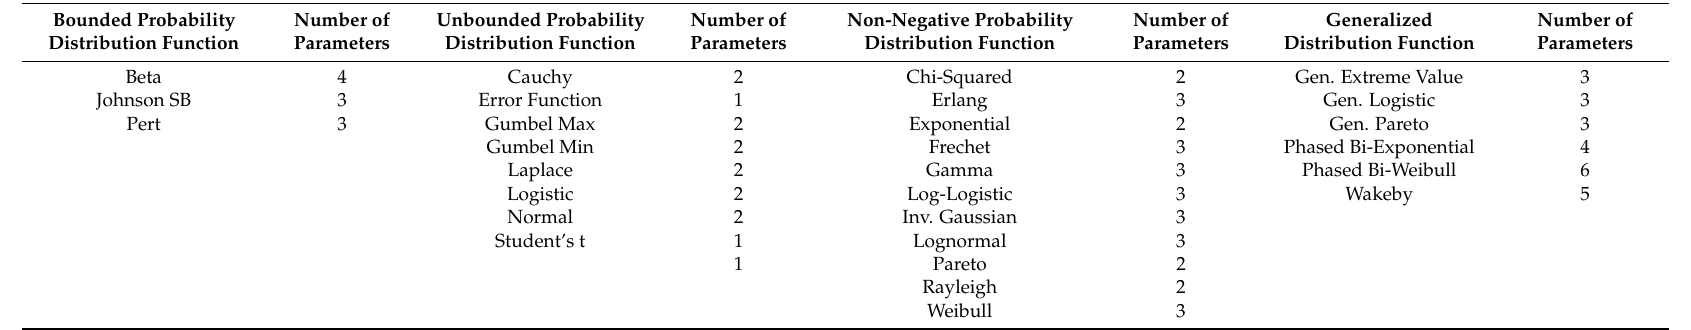
Table 3. Four kinds of probability distribution